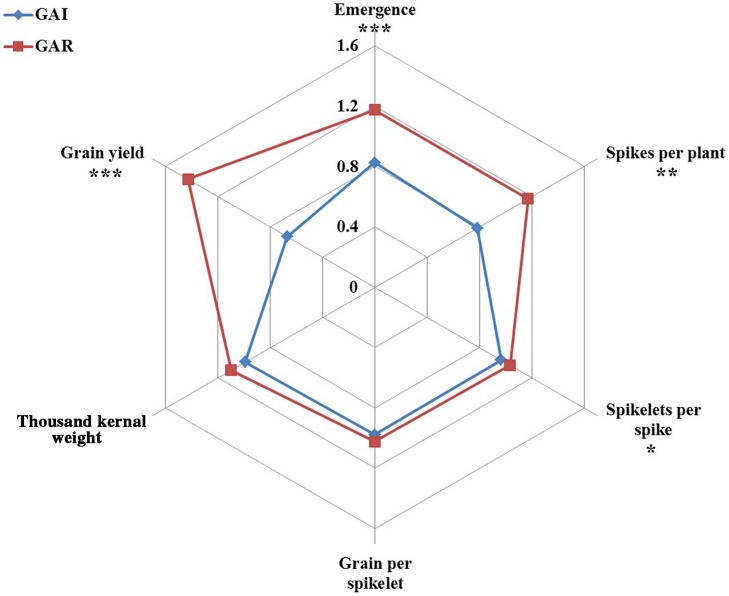
Radar charts comparing the traits of yield and yield components of GAI (blue) and GAR (red) plants under deep sowing. Six individual plots per line were used in each of the measurements, and the data were subjected to one-way ANOVA followed by Student’s t-test. Asterisks indicate significance: ∗P ≤ 0.05, ∗∗P ≤ 0.01, and ∗∗∗P ≤ 0.001.